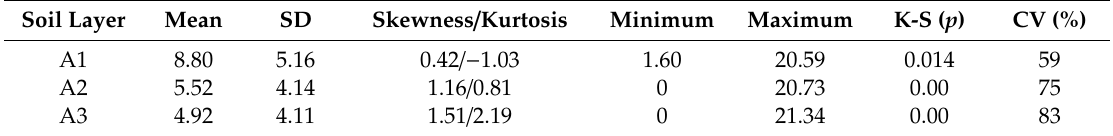
Table 1. Descriptive statistics of soil iron content under di ff erent soil depths (mg · kg − 1 ). Soil Layer Mean SD Skewness /